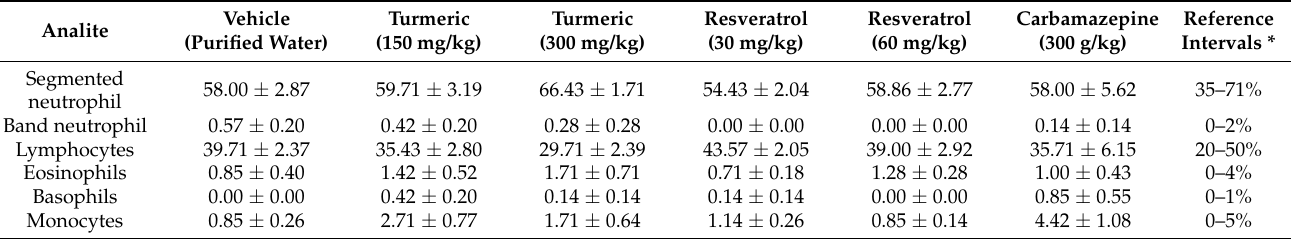
Table 4. Post-status epilepticus leukocyte differential count of rats treated with the vehicle, turmeric, resveratrol, or